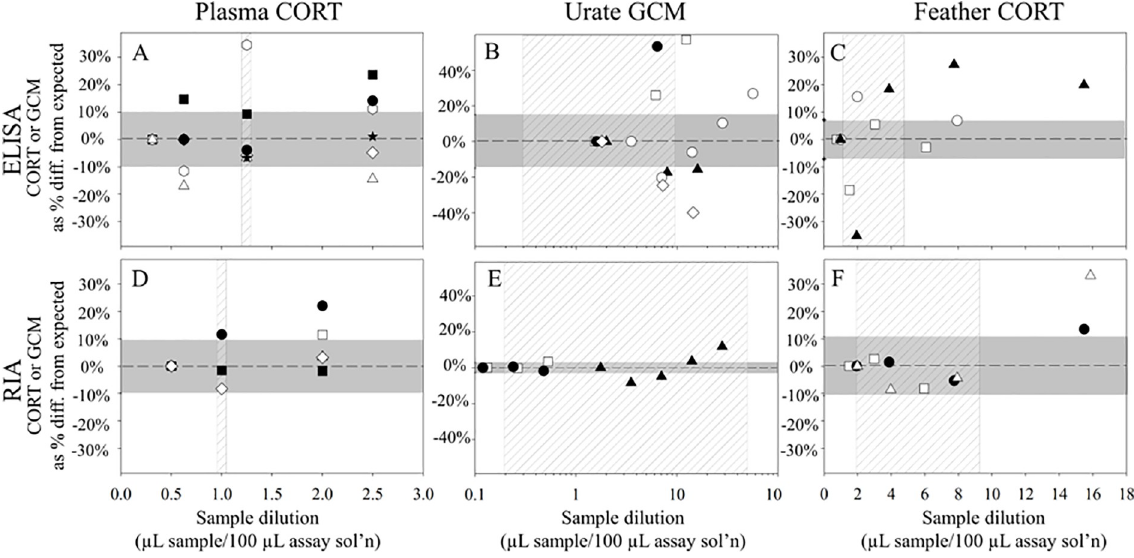
Fig 1. Plasma corticosterone (CORT) (A and D), urate glucocorticoid metabolites (GCM) (B and E), and feather CORT (C and F) levels measured by radioimmunoassay (RIA) are more reproducible than enzyme-linked immunosorbent assay (ELISA) across a range of sample dilutions . Symbols (open and filled squares, circles, triangles, and diamonds) represent a sample from an individual condor that was analyzed over a range of sample dilutions. CORT and GCM levels in diluted samples are expressed as a percent difference from expected values (horizontal dashed line at 0% diff.), based on levels measured in the most dilute sample (i.e., the lowest amount of sample in milligrams per 100 μ L assay solution), and assumes sample matrix interferences are minimized in this most dilute sample. The vertical hash-marked region in each panel reflects the range of sample dilutions (x-axis) used for all samples in this study. The horizontal grey-shaded region reflects the CORT or GCM measurement uncertainty ( ± 2 RSD, based on intra-assay precision) for each assay and sample type; symbols within this region do not measurably differ from expected GC